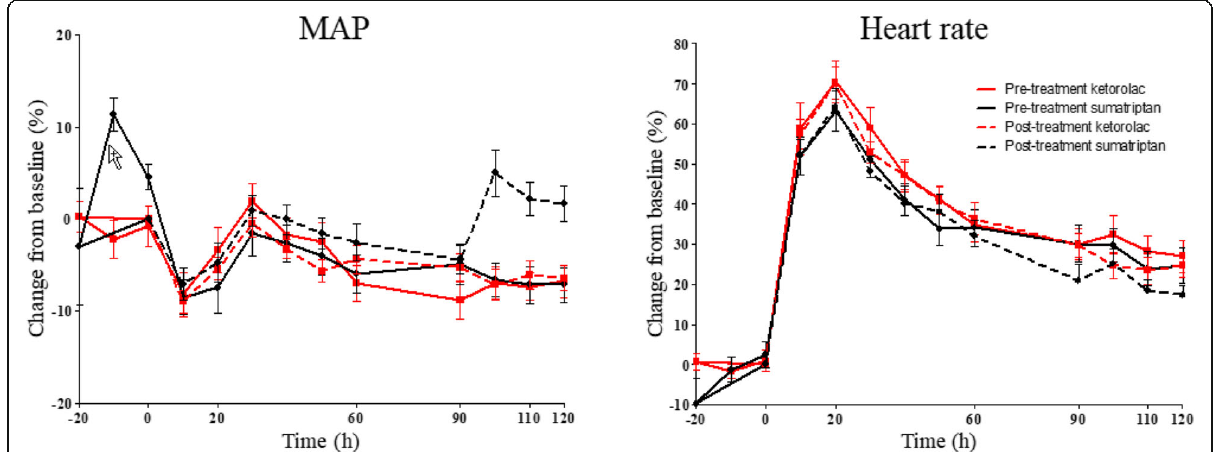
Fig. 4 Percentage change from baseline for mean arterial pressure (MAP) and heart rate (HR) after PACAP38 and pre-treatment and post- treatment with ketorolac and sumatriptan